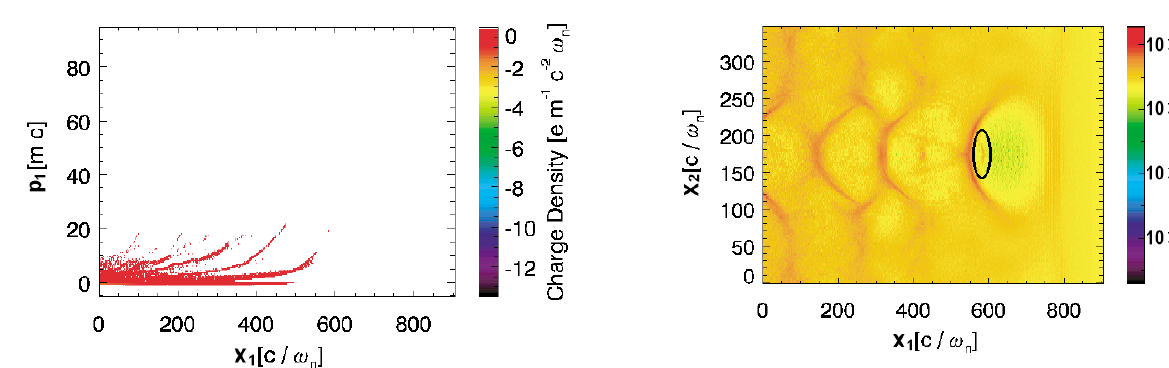
FIG. 2. (Video) A typical longitudinal phase space density plot of the plasma electrons at the time when the laser has just exited the first gas jet. The gas-jet parameters in this simulation are w 1 (cid:1) 1.5 mm, L g 1 (cid:1) 0.5 mm, and n p 1 (cid:1) 7.07 3 10 18 cm 2 3 . See videos 1 and 2 for the dynamic development of the phase space.